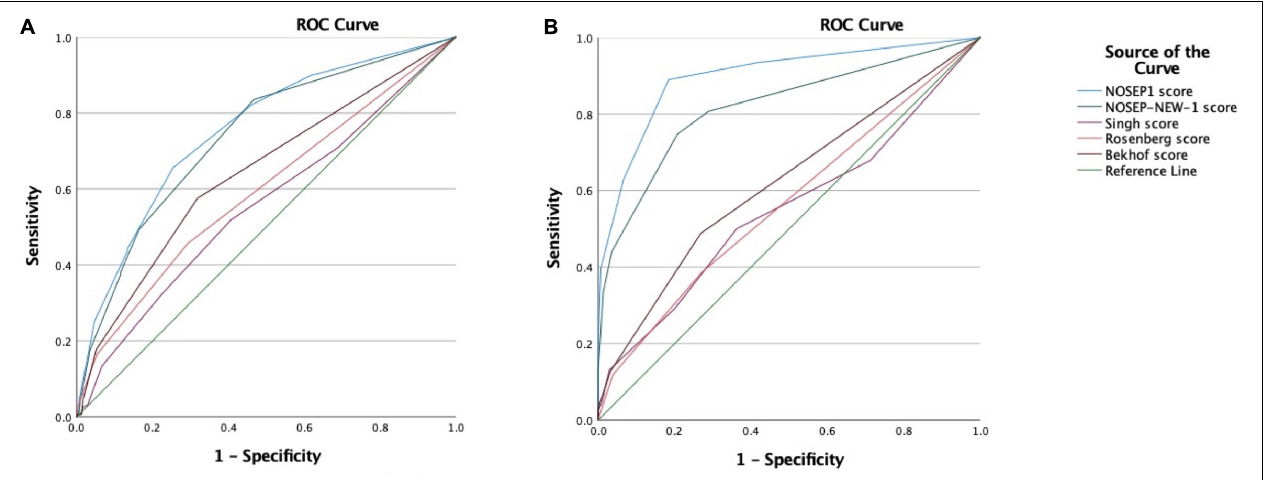
FIGURE 2 | (A) Graph showing the receiver operating characteristic (ROC) curves for the analysis of the diagnostic accuracy of the NOSEP1 score (area under curve 0.753), NOSEP-NEW-1 score (area under curve 0.737), Singh score (area under curve 0.555), Rosenberg score (area under curve 0.594), and Bekhof score (area under curve 0.641), for the prediction of proven hospital-acquired infection. (B) Graph showing the ROC curves for the analysis of the diagnostic accuracy of the NOSEP1 score (area under curve 0.898), NOSEP-NEW-1 score (area under curve 0.820), Singh score (area under curve 0.550), Rosenberg score (area under curve 0.566), and Bekhof score (area under curve 0.620), for the prediction of proven hospital-acquired infection and/or presumed hospital-acquired infection. The reference line on both graphs represents a curve with no predictive value (area under curve = 0.50).